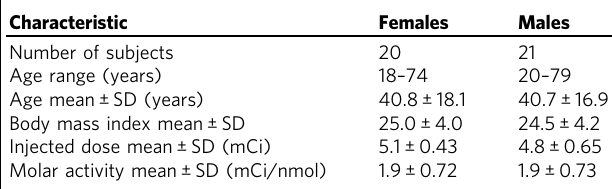
Fig. 3 HDAC1 and HDAC2 expression is increased in the white matter of elderly donors. Whole-cell lysates were prepared from post mortem periventricular white matter and corpus callosum tissues. Protein expression of HDAC paralogs (1, 2, 3, and 6) were compared between younger donors ( n = 9, 16 – 21 years -old) and older donors ( n = 9, 76 – 100-years-old) by western blotting (two-tailed unpaired t -test; false discovery rate (FDR) corrected for multiple comparisons). For each paralog, immunoreactive band intensity was normalized by GAPDH and scaled to a mean of 1. Box plots display median, fi rst quartile, third quartile, and range (min – max) from a , b periventricular white matter and c corpus callosum. See Supplementary Figs. 10 and 11